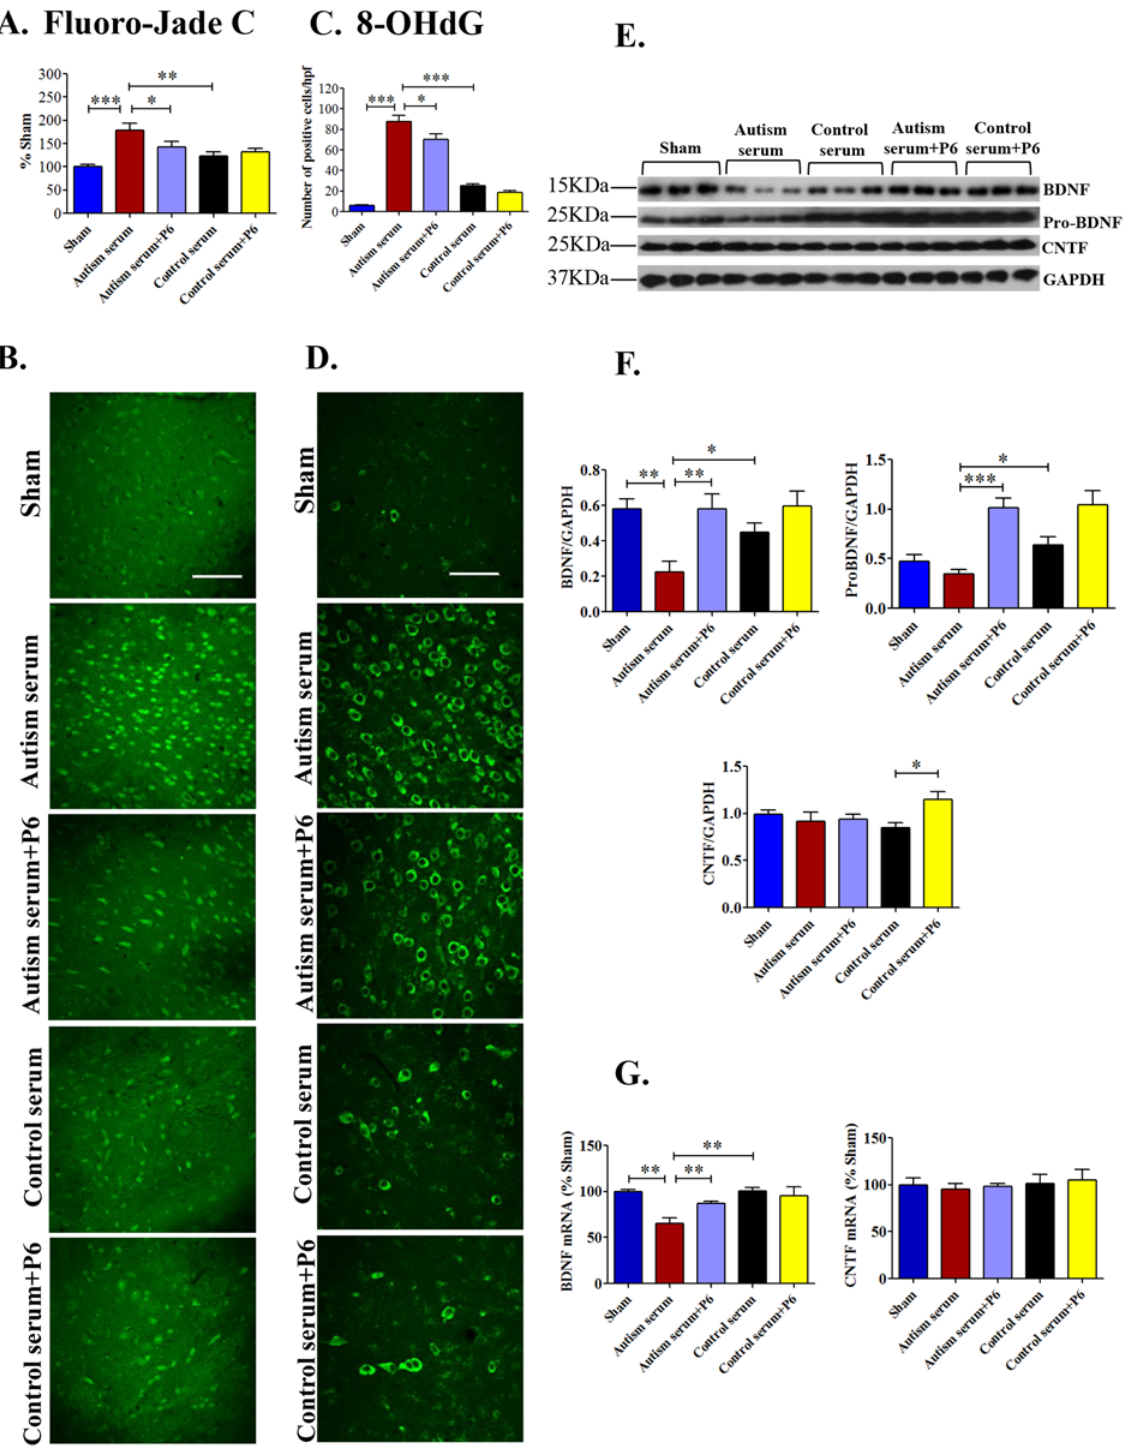
Fig 6. Effect of autism and control sera in the presence or absence of P6 on neurodegeneration, oxidative stress, and CNTF, BDNF, and pro-BDNF expression in the cerebral cortex of young Wistar rats. P 0.5 rats were injected intracerebroventricularly with saline (sham) or 2% autism or control serum with or without 20 nM P6. On postnatal day 26 – 27, rats were sacrificed and their brains were evaluated by quantitative immunohistochemistry and Western blots ( A and B ) Quantification and representative images of Fluorojade C staining, a sensitive marker of neurodegeneration, in the cerebral cortex are shown. Quantification is based on minimum of 6 animals/group (including 2 animals for each serum sample injected). ( C and D ) Quantification and